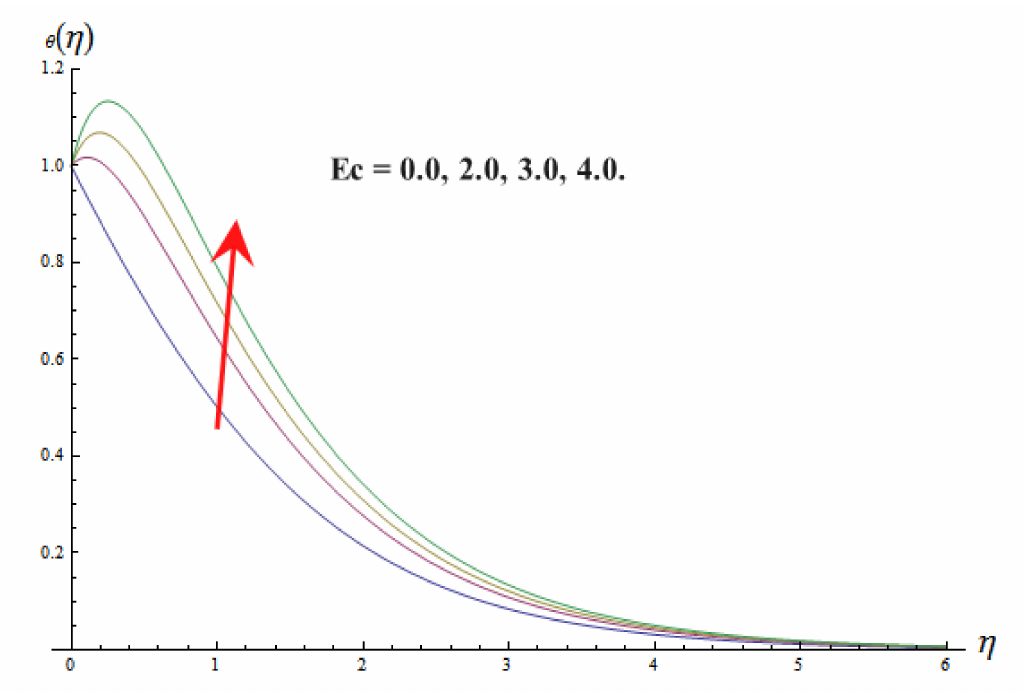
Figure 8. Impact of Ec on θ ( η ) keeping λ 1 = 2, Pr = 2, Br = 2, λ = 2, Γ = 0.2, Rd = 2, β 1 = 0.2, Ha = 2, K ∗ = 2.